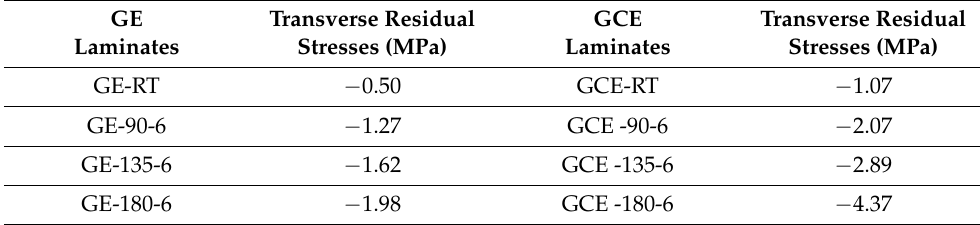
Figure 8. Longitudinal residual stress in each lamina determined from recorded longitudinal strains for all GCE laminates. Table 3. Overall transverse residual stresses in GE and GCE laminates.